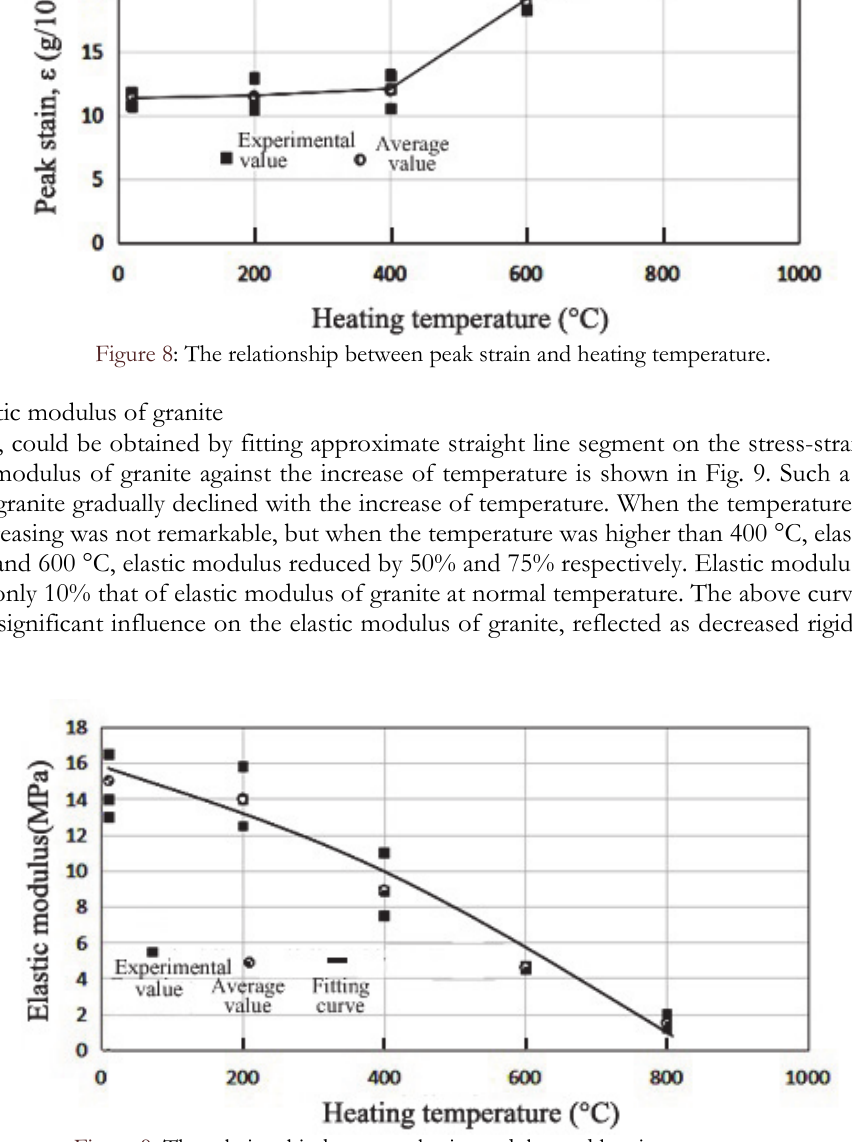
Figure 9: The relationship between elastic modulus and heating